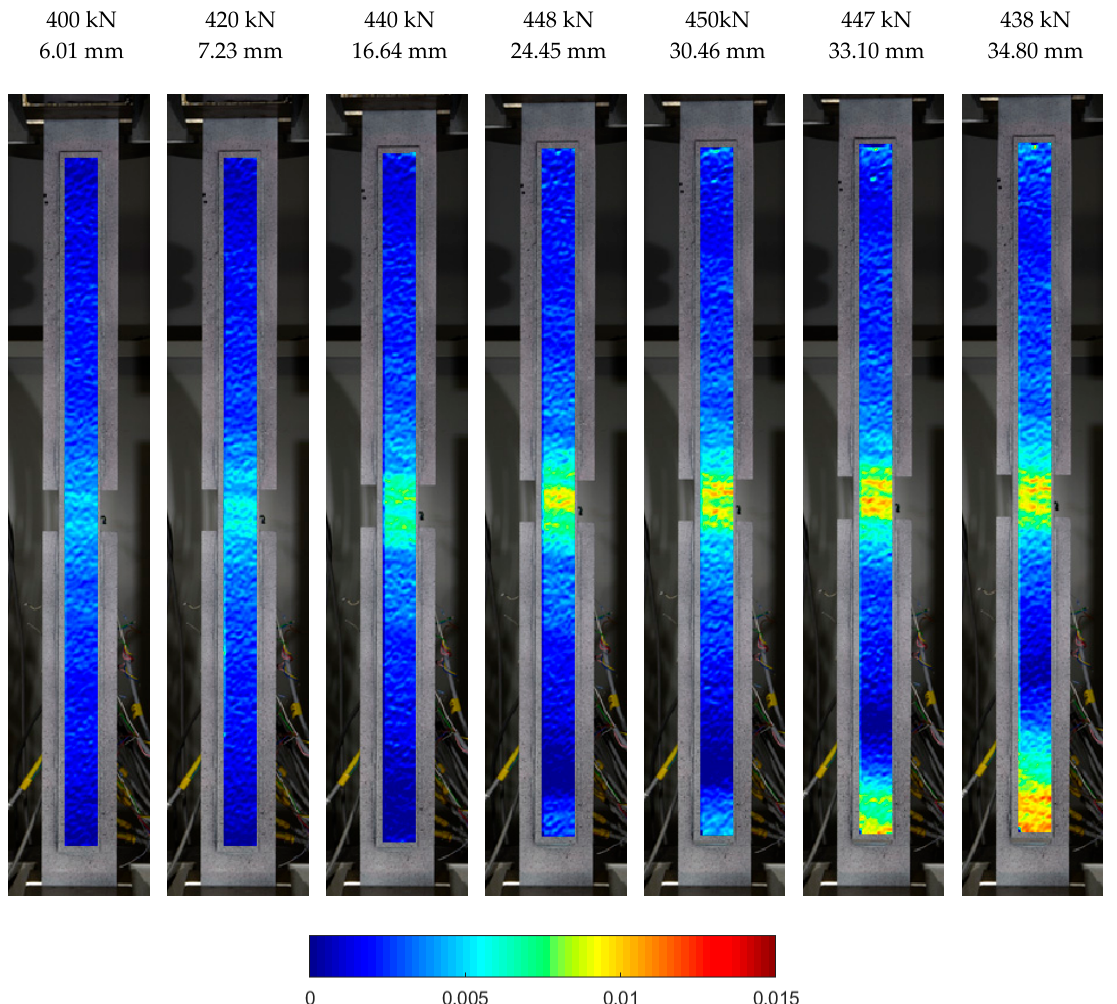
Figure 9. Longitudinal strain distribution maps at yielding and failure in S/DL/MA/RS-400-4/P2.